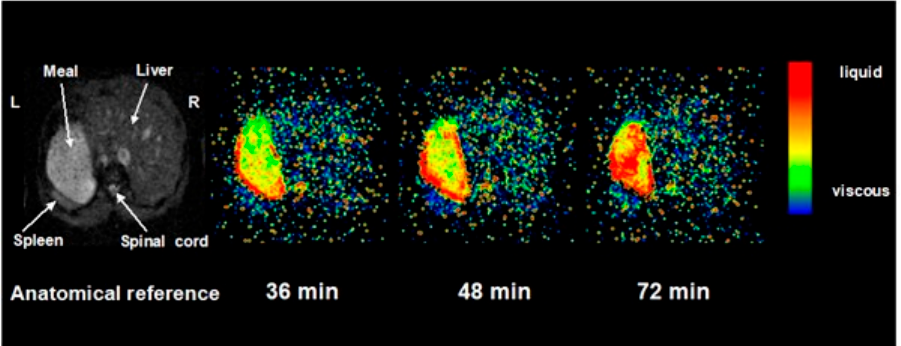
Figure 3. The time constant of the decay of image intensity (T2) maps of the stomach after ingestion of locust bean gum with viscosity of 17 Pa · s. Reproduced from [11], American Physiological Society 2001, with permission.